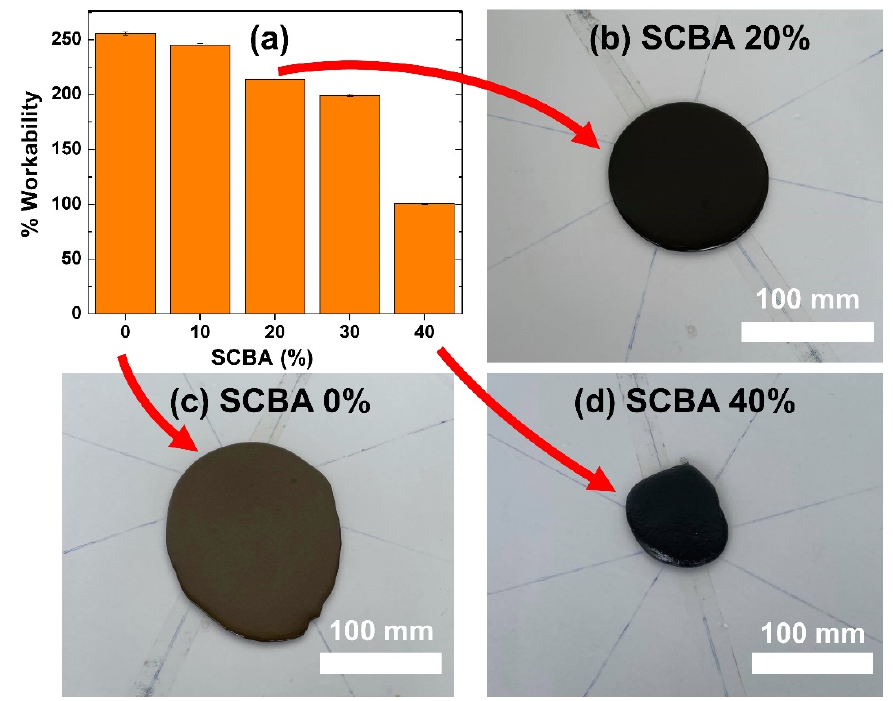
Figure 3. ( a ) Workability of the geopolymer/SCBA pastes; ( b – d ) the spread of geopolymer pastes during workability tests.